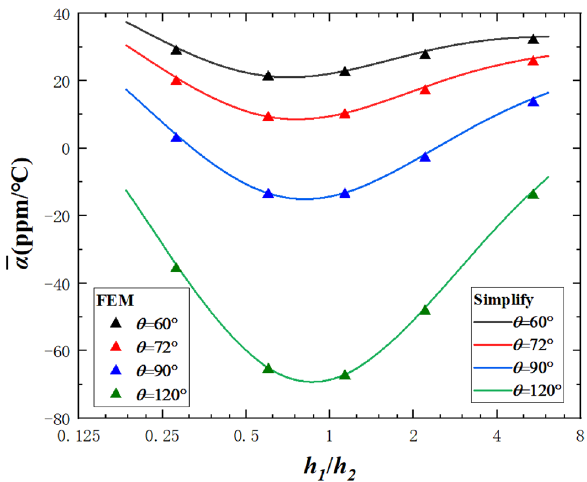
Figure 5. The effects of h 1